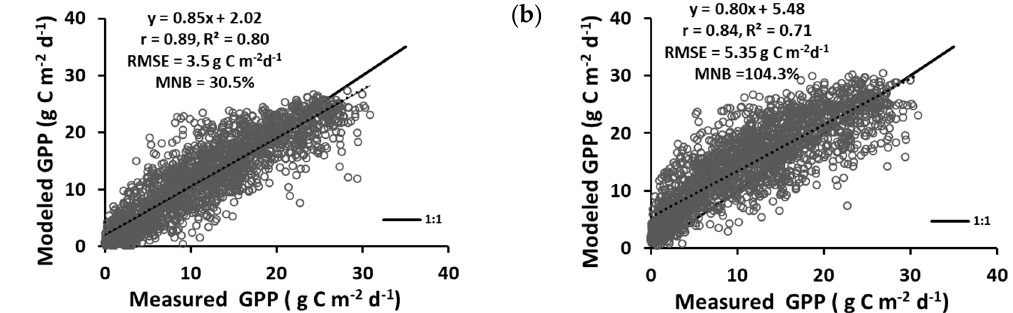
Figure 8. AmeriFlux measured GPP plotted as a function of LUEc modeled GPP when ( a ) all scalar values are used; ( b ) all scalar values are set to 1 and the model is run as a pure LUE model with the scalars completely negated.